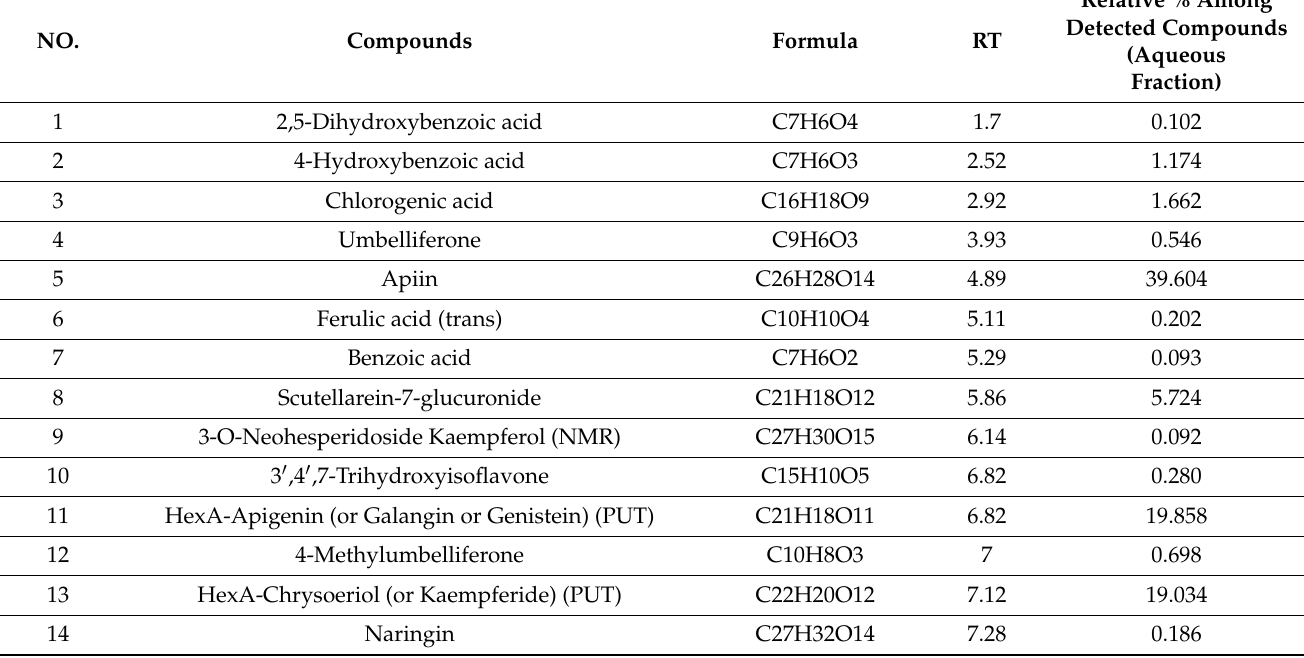
Table 5. LC-MS analysis of X. spinosum aqueous